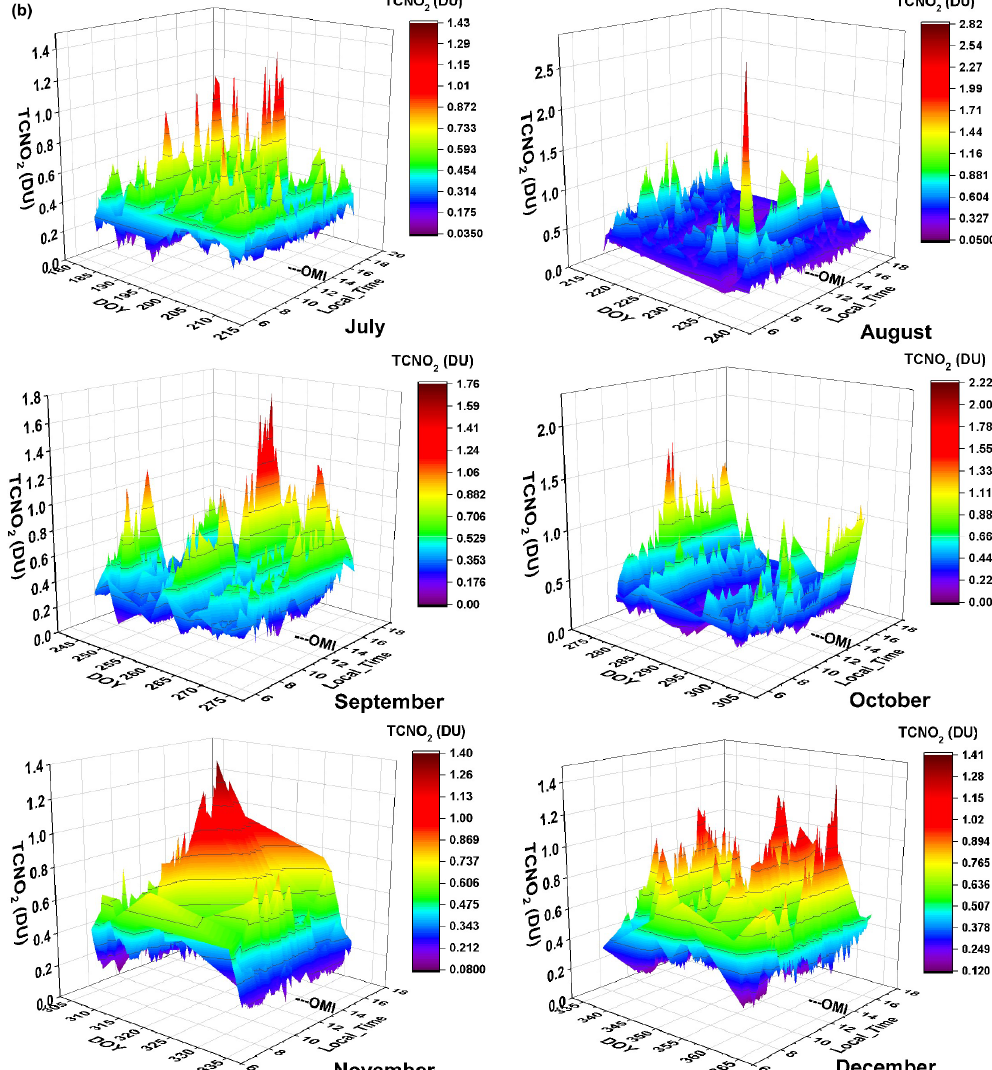
Figure 8. (a) TCNO 2 diurnal variation (DU) from January to June, NASA Headquarters, Washington DC, from January to June 2015. The approximate OMI overpass time near 13:30 is marked. (b) TCNO 2 diurnal variation (DU) from July to December, NASA Headquarters, Washington DC, from July to December 2015. The approximate OMI overpass time near 13:30 is